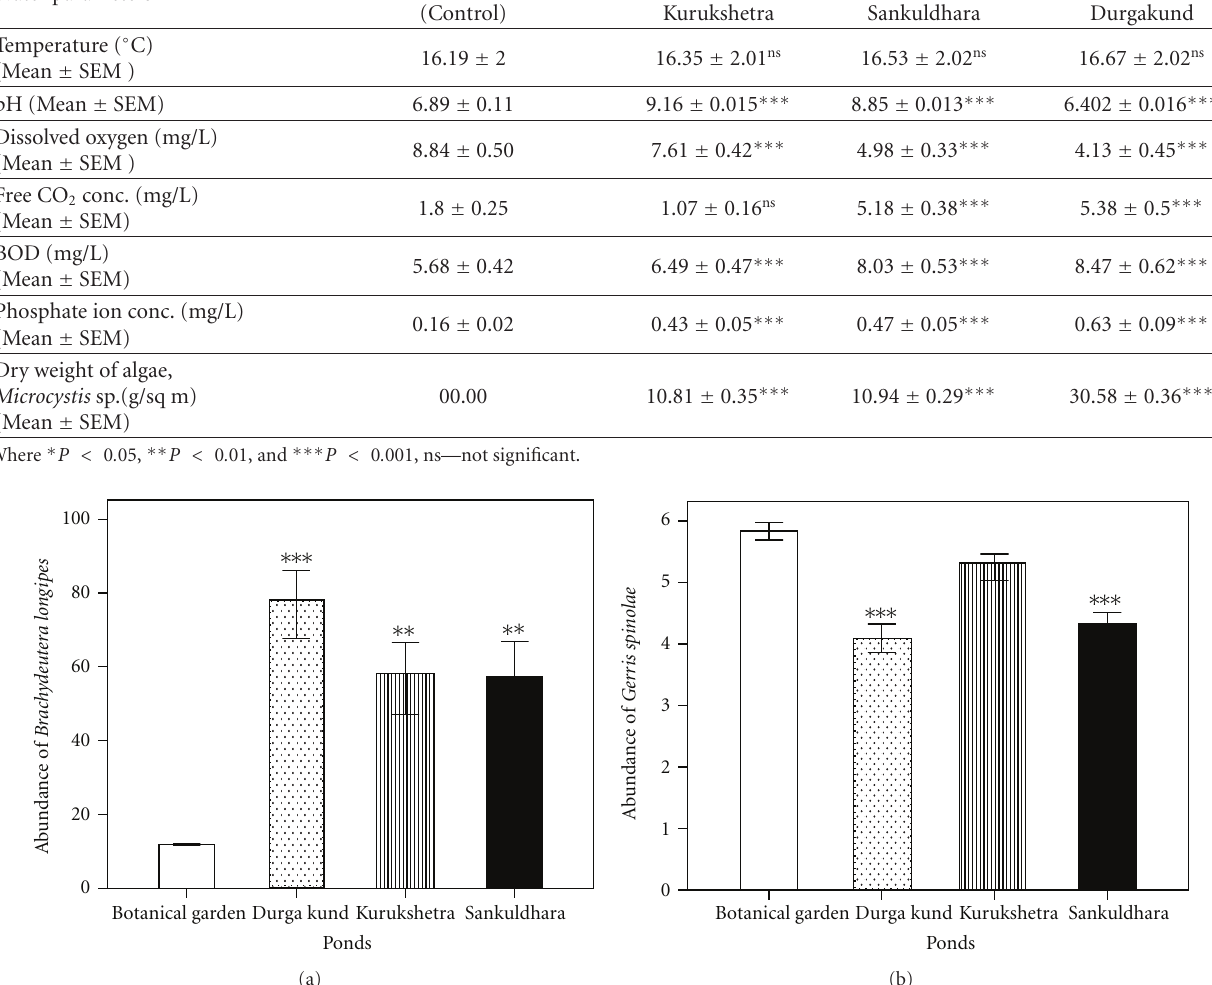
Table 1: Physical, chemical, and biological parameters of water quality in the four ponds (Botanical garden—control; Kurukshetra, Sankuldhara and Durgakund—anthropogenically stressed) located in di ff erent parts of Varanasi, India. Water parameters